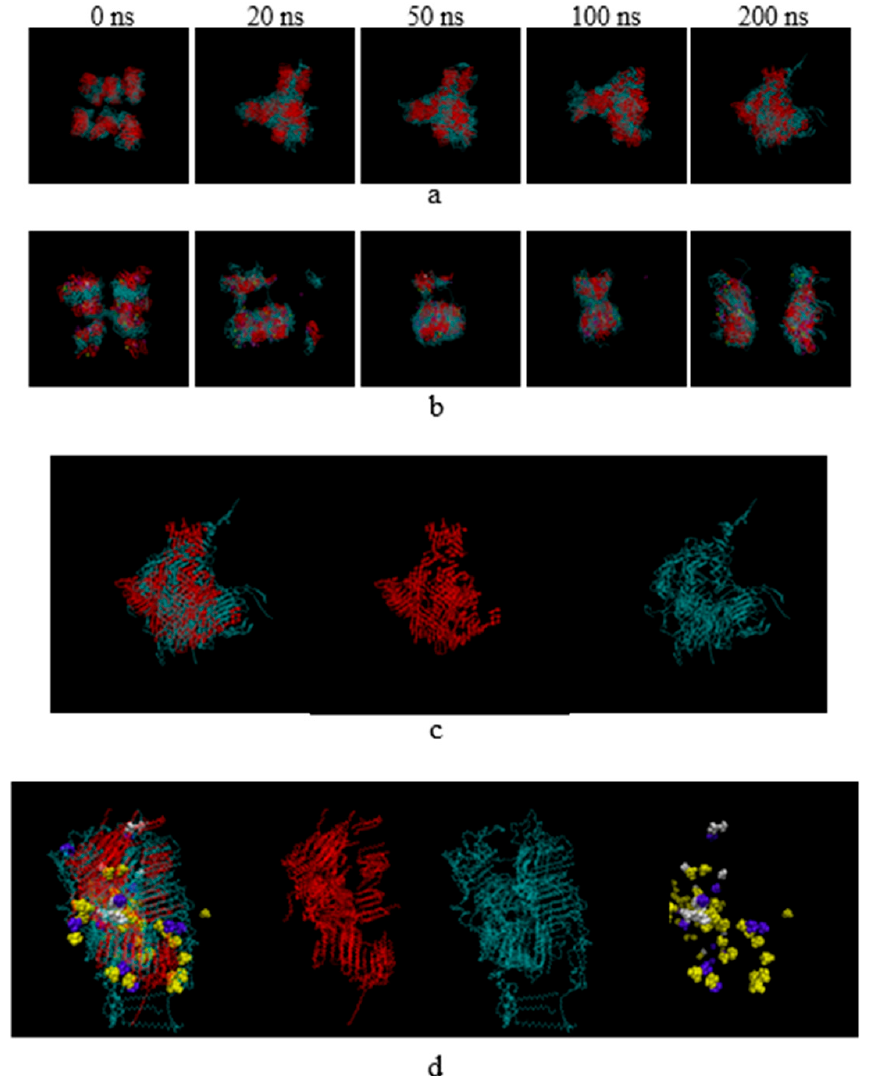
Figure 7. Computer simulation of SLNs without ( a ) and with RMO ( b ) during the simulation time from 0 to 200 ns. Self-assemblies of SLNs separated into each component without ( c ) and with ( d ) RMO at 200 ns. Red and blue represent TLR and CRH40, respectively, whereas white, violet, and yellow represent RMO including alpha-pinene, camphor, and eucalyptol, respectively.